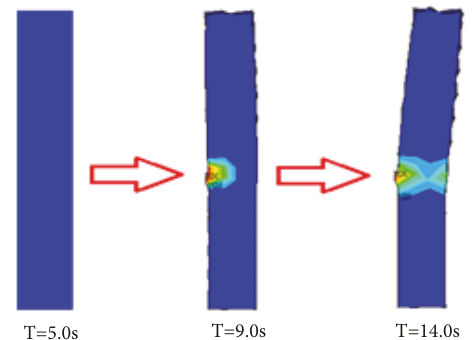
Figure 14: The plastic strain cloud diagram of stabilizing pile at different vibration times.